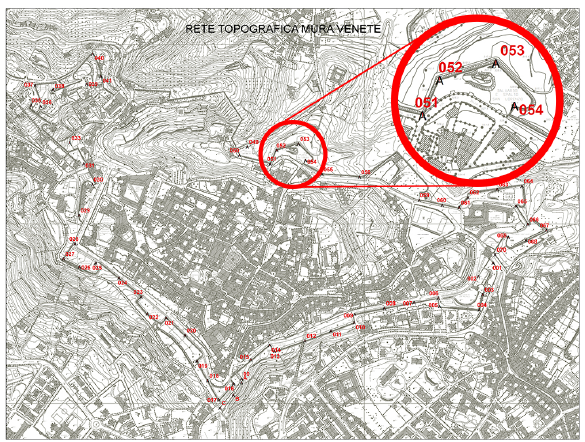
Figure 3. Topographic reference network around city